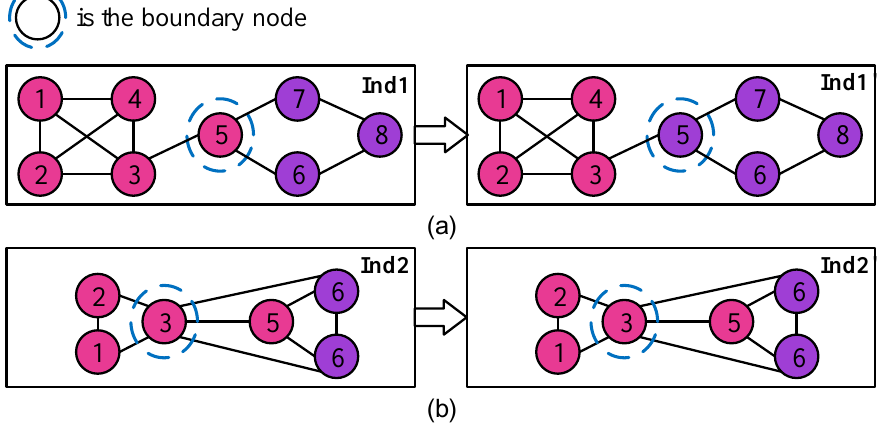
Figure 7. Boundary node mutation in DECS. ( a ) The performance of Ind1 has been improved. ( b ) The performance of Ind2 has been